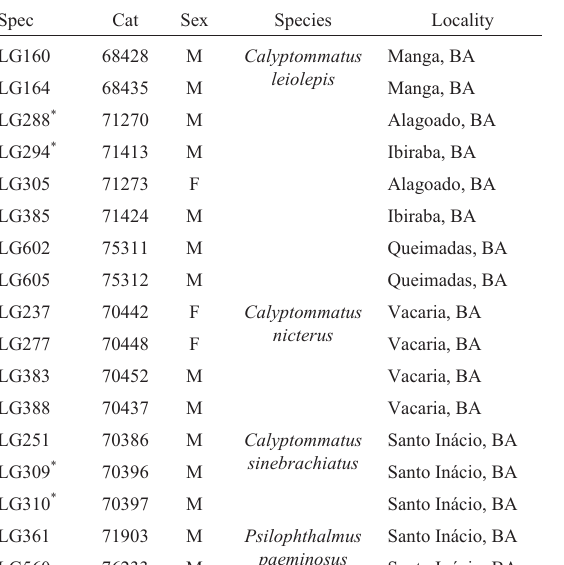
Table 1 - Specimen identity code, voucher number, sex, species and locality of microteiid lizards sampled in this